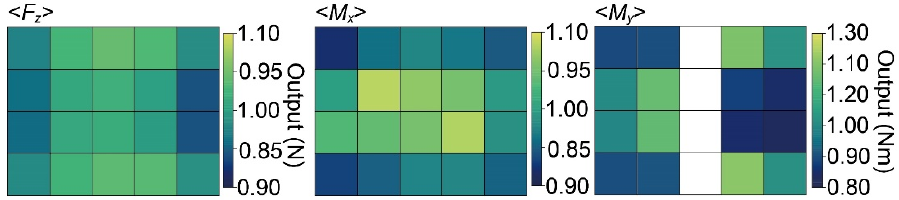
Figure 10. Positional errors in F z , M x , and M y , calculated by the measured data.